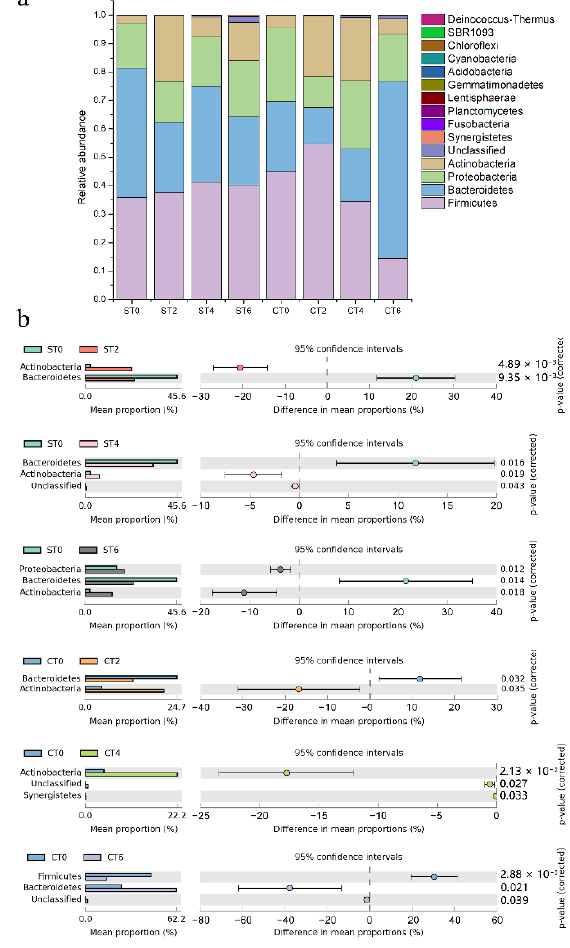
Figure 3. Bar and differential analysis charts of the relative abundance of phyla in the intestinal lumen microflora. ( a ) Bar chart of the relative abundance of microbial phyla in the colonic lumen. ( b ) Difference analysis chart between groups (ST — aqueous extract group; CT — alcohol extract group; 0 — no sample added; 2, 4, 6 denote fermentation days after sample addition).